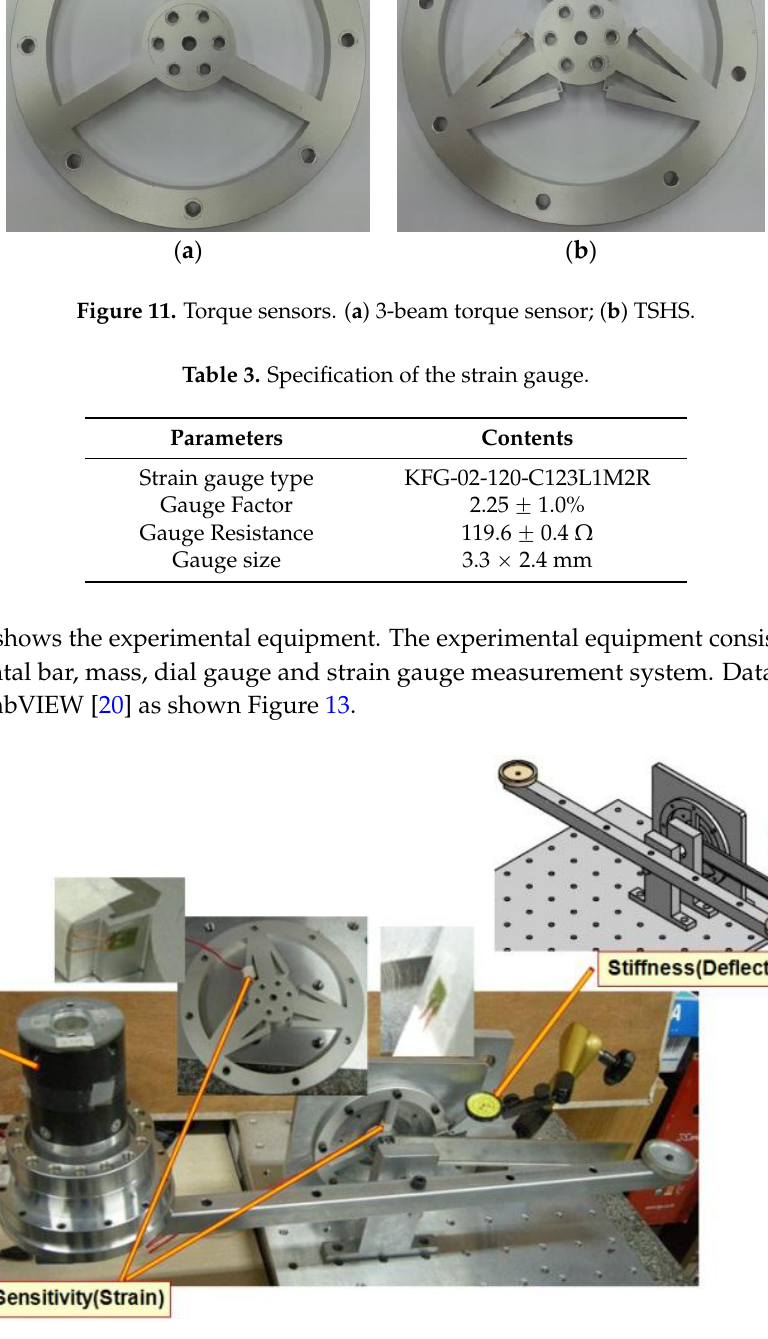
Figure 13. Program in LabVIEW.